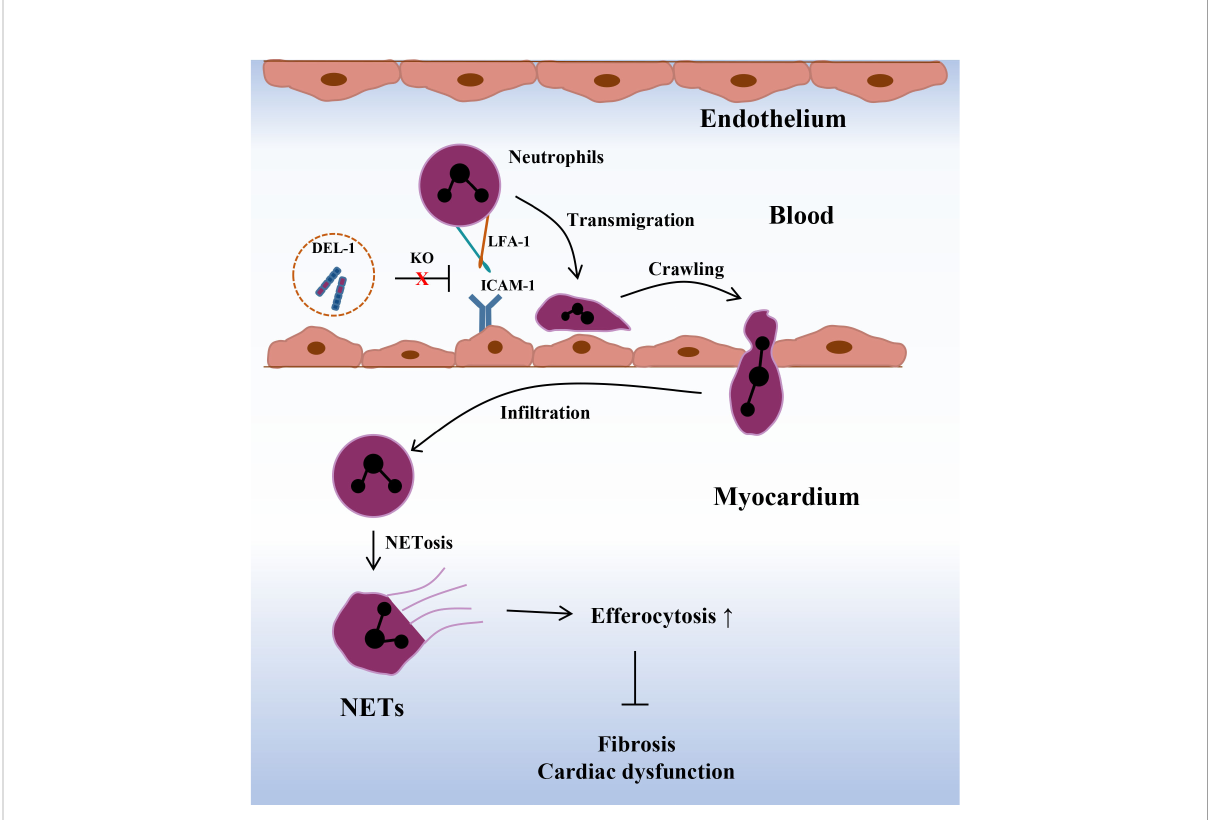
FIGURE 5 Deletion of DEL-1 promotes neutrophil in fi ltration and formation of NETs, thereby promoting macrophage efferocytosis and alleviating cardiac fi brosis and cardiac dysfunction after MI. DEL-1, developmental endothelial locus-1; NETs, neutrophil extracellular trap; MI, myocardial